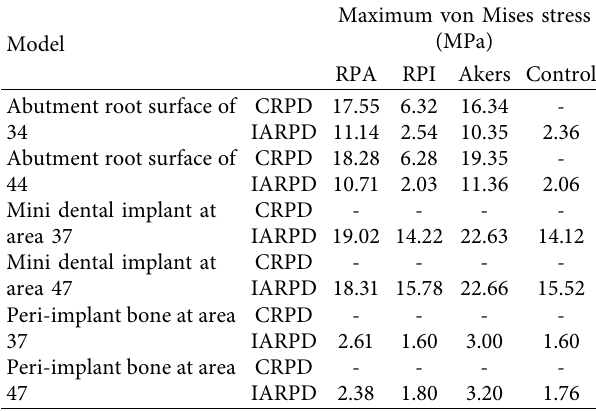
Figure 8: The stress distribution pattern on the mini dental implant and the peri-implant bone when applied vertical load of 200N on the edentulous ridge areas of IARPD with different retentive clasp designs. Table 3: Maximum von Mises stress values (MPa) in each